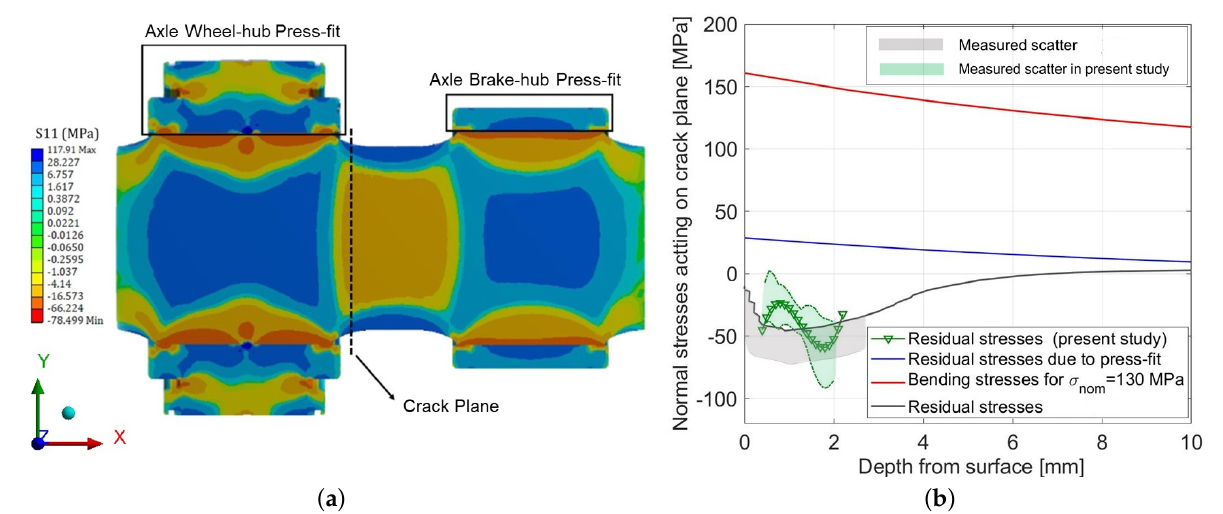
Figure 7. Stress analysis in the notch section for applied nominal stress of 130 MPa (rearranged from the work in [55]): ( a ) longitudinal stresses induced by the press-fit and ( b ) calculated in-depth stress profiles due to the rotating bending and press-fit and manufacturing induced compressive residual stresses (the value of the measured scatter marked with grey is acquired from [62]; the value of residual stress marked as black line is acquired from